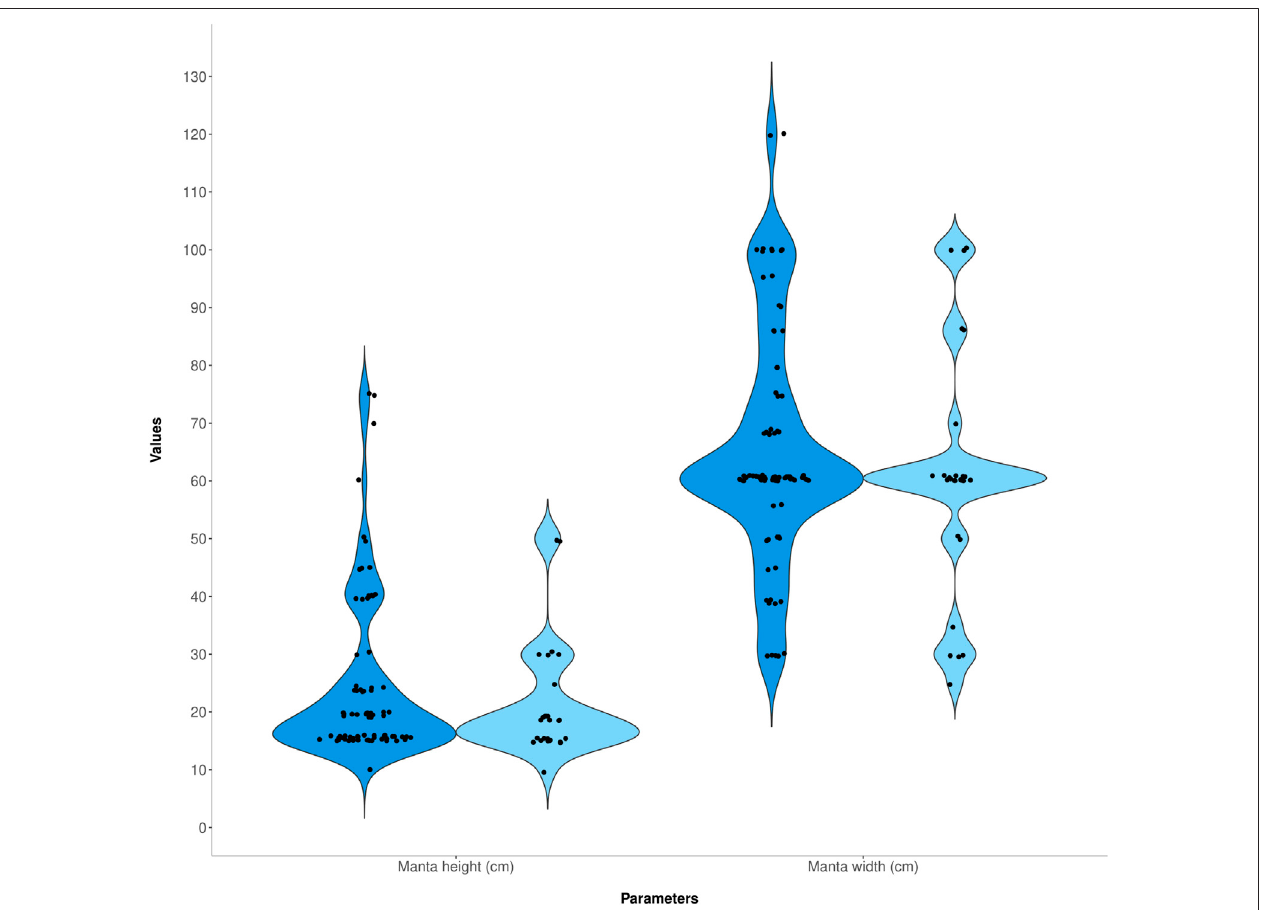
FIGURE 3 | Distribution of Manta height and width in the reviewed literature, including studies of both saltwater (dark blue) and freshwater (light blue).